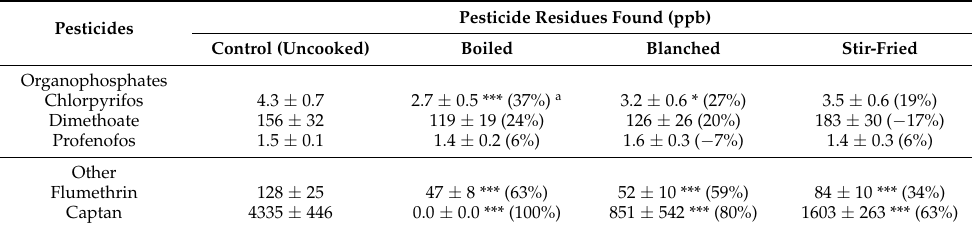
Table 4. Effects of boiling, blanching and stir-frying on removing pesticide residues in yard long bean. Pesticide Residues Found (ppb) Pesticides Control (Uncooked) Boiled Blanched Stir-Fried Organophosphates Chlorpyrifos 4.3 ± 0.7 2.7 ± 0.5 *** (37%)